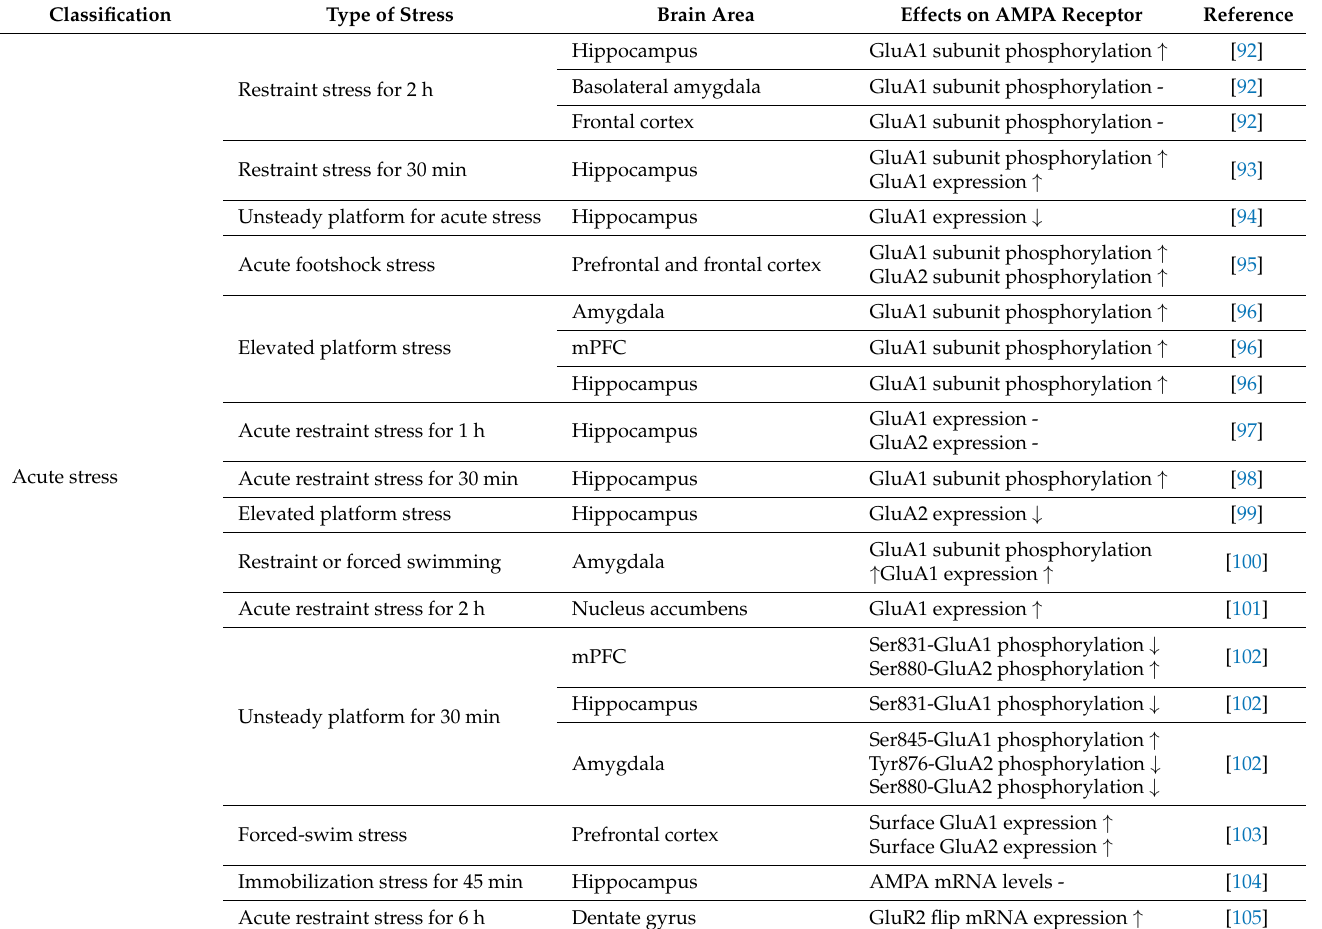
Table 1. Effects of AMPA receptor response to different stress paradigms. ↑ = increase; ↓ = decrease; - = no